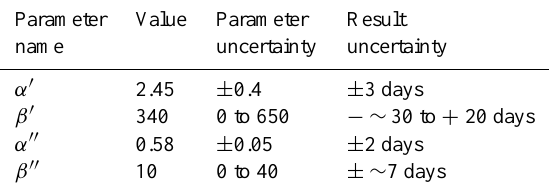
Table 2. Summary of parameter values, uncertainty ranges, and the resultant impact of these ranges on ice on/off